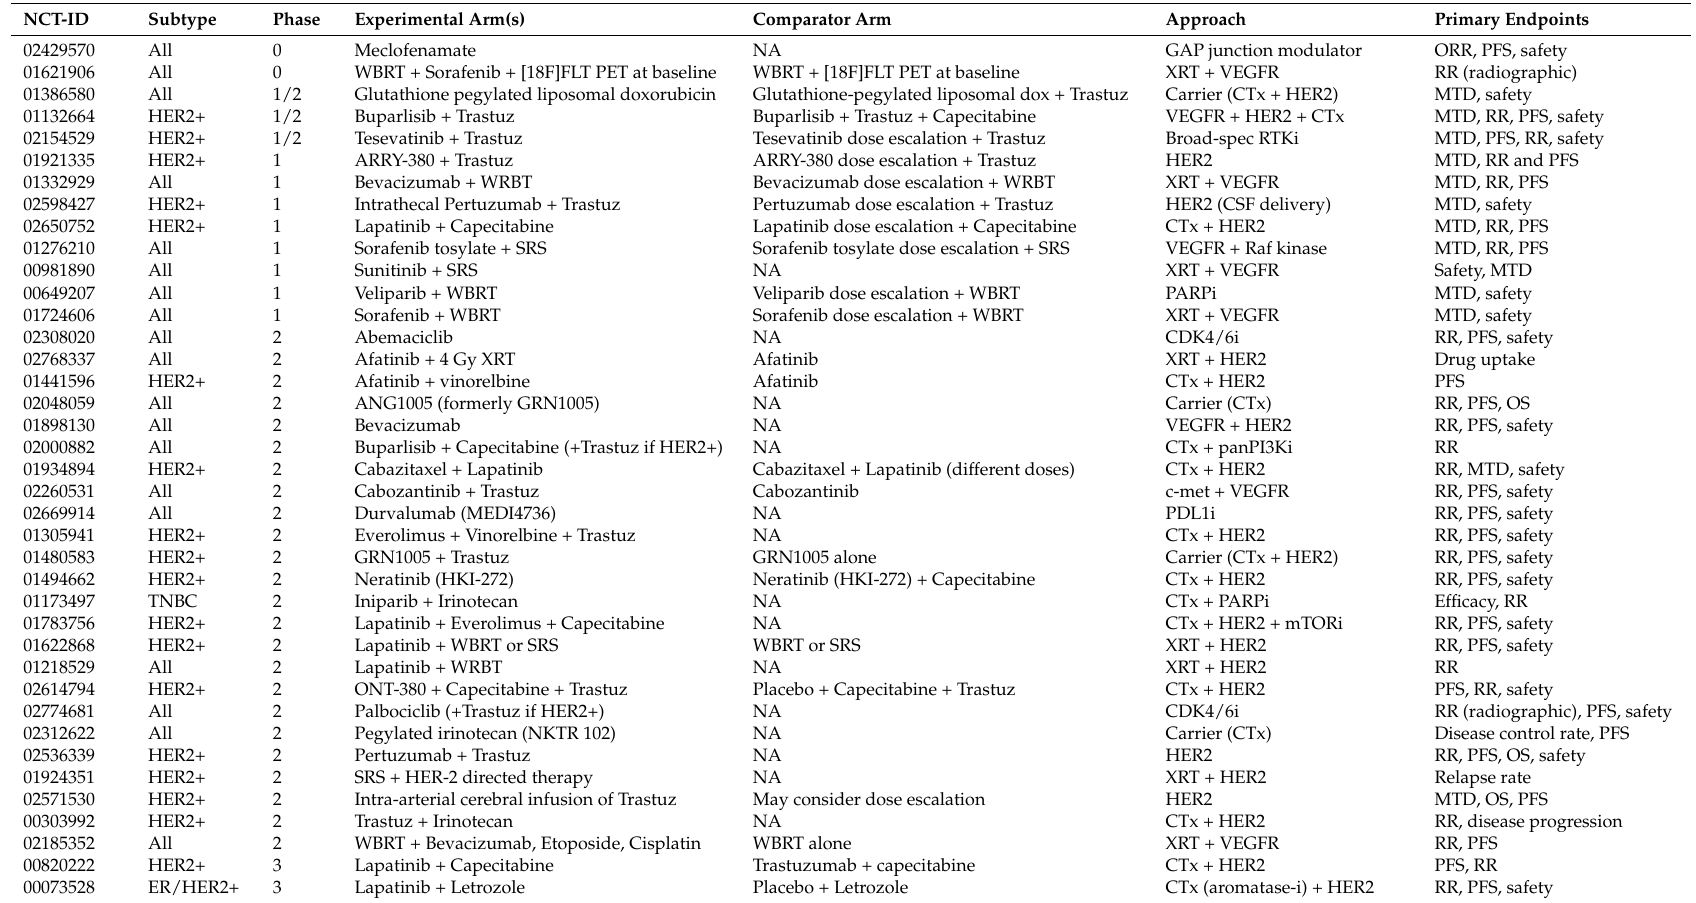
Table 1. Summary of current clinical trials of molecular-targeted agents for breast cancer patients with established brain metastases